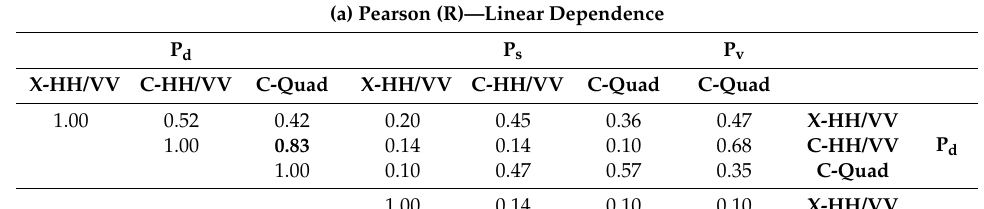
Table 5. Average Pearson ( a ), squared Pearson (b ) and Spearman ( c ) correlation coefficients of C-Band Radarsat-2 and X-Band TerraSAR-X data for two and three component decomposition features double bounce (P d ), surface scattering (P s ), and volume scattering (P v